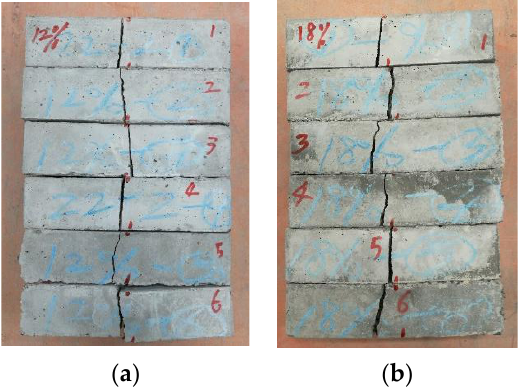
Figure 22. Failure modes of CRM specimens. ( a ) Sample with 12% rubber content. ( b ) Sample with 18% rubber content. Table 10. Test results of flexural strength.